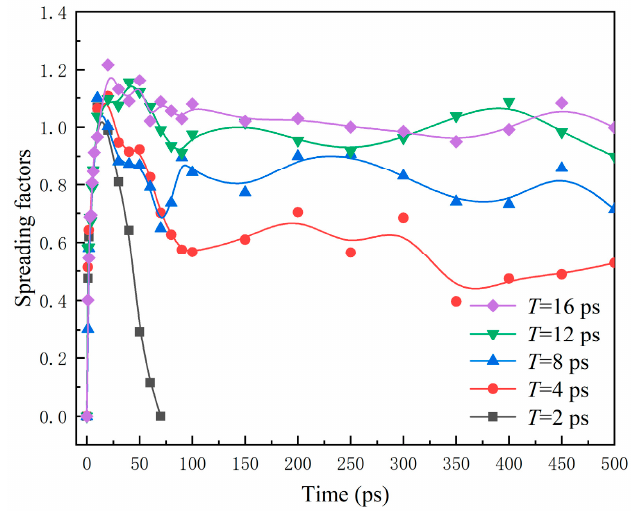
Figure 17. Spreading factors of water nanodroplets impinging on solid surfaces with various vibra- tion periods .